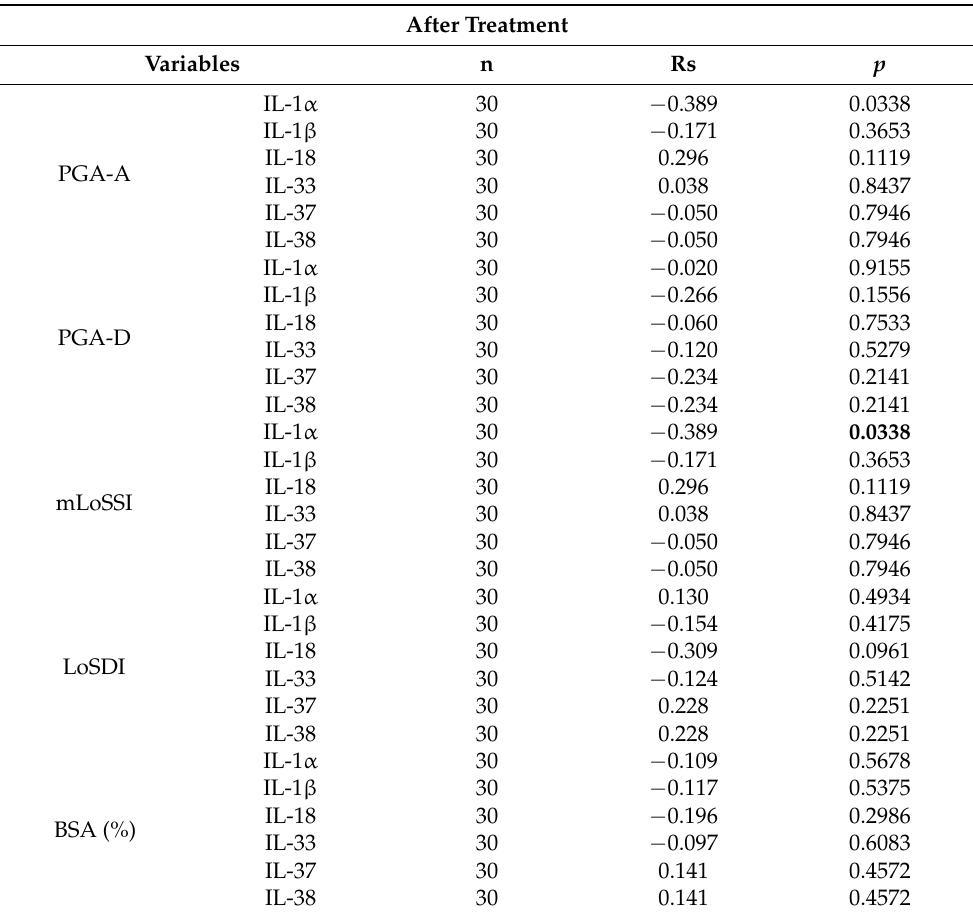
Table 10. Correlations between disease-targeted measures and levels of selected cytokines in LoS group after